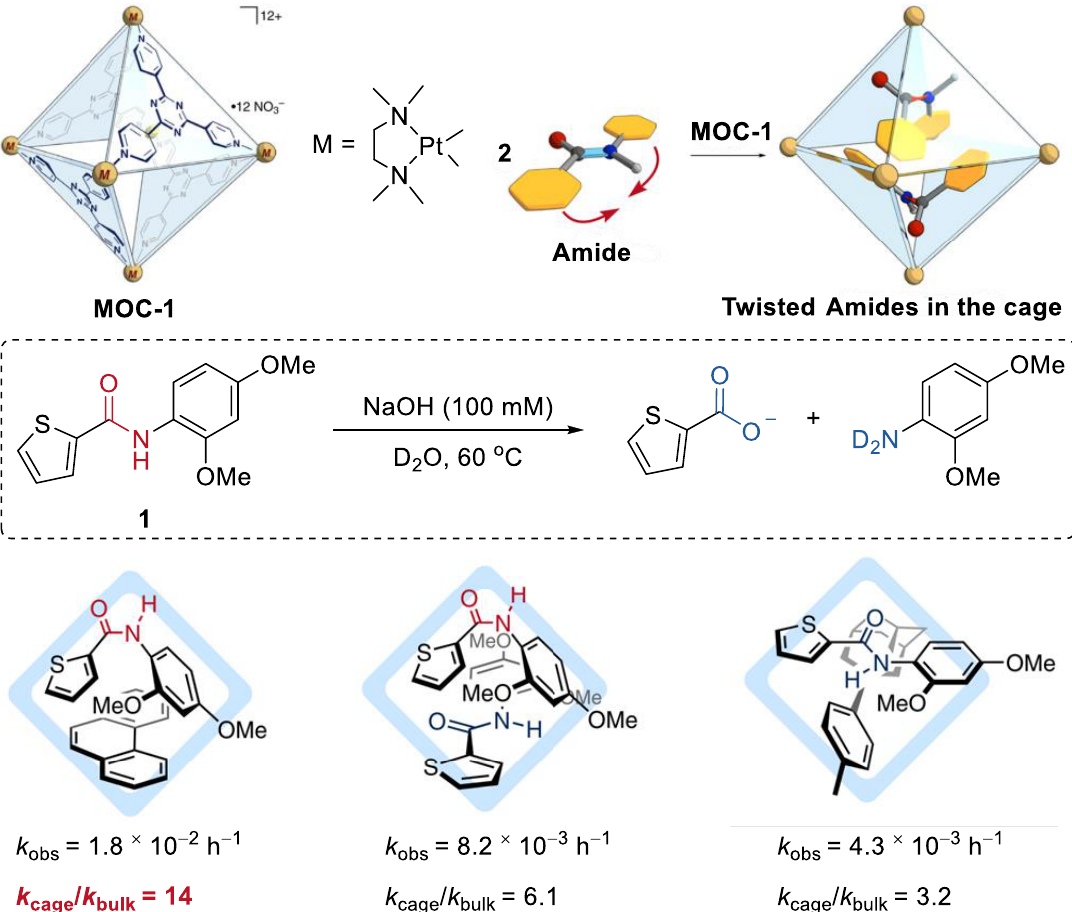
Figure 1. Hydrolysis of amides catalyzed by MOC-1 by mechanically twisting them within the cavity of the cage [39]. Reaction additions: 1 (2.4 mM), co-encapsulated guest agent (1.05 eq.), MOC-1 (2.4 mM), NaOH (100 mM), 60 °C, D 2 O. Reprinted/adapted with permission from Ref.